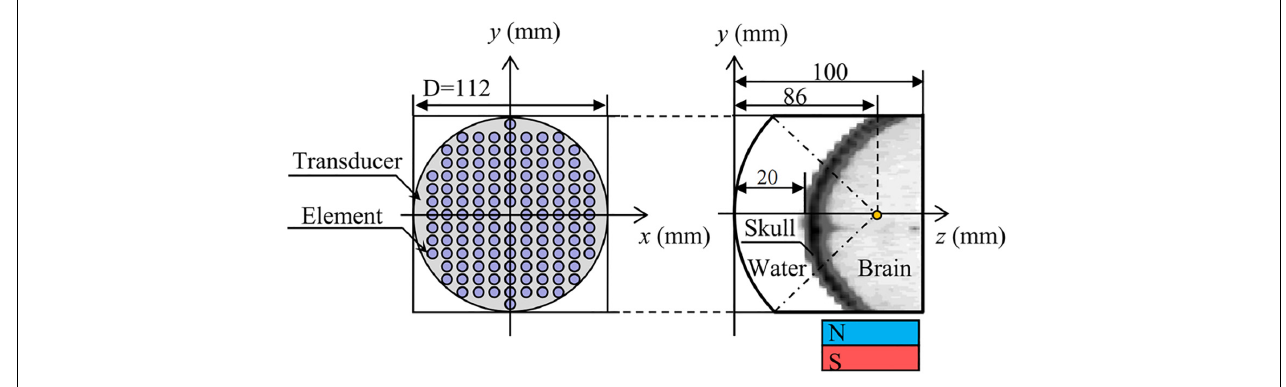
FIGURE 1 | Numerical simulation model of transcranial focusing of a concave spherical phased transducer with 128 elements.